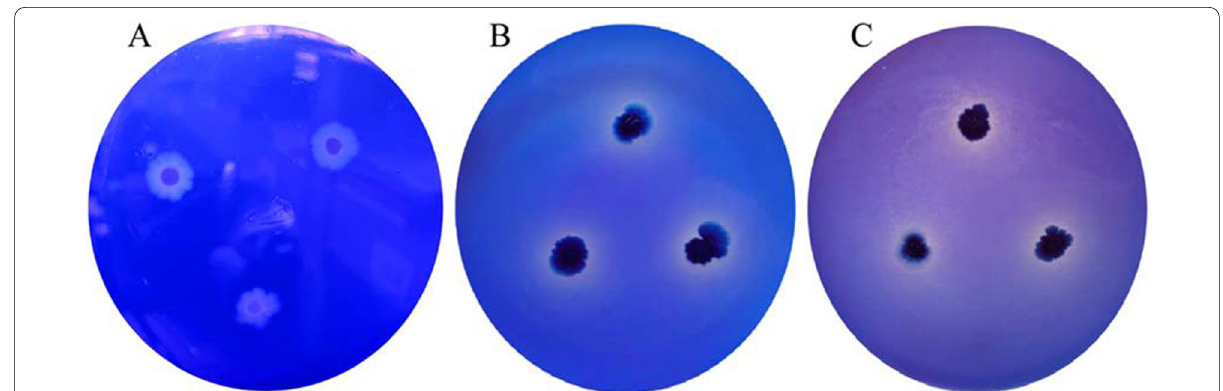
Table 3 Analysis of soil physicochemical properties Items